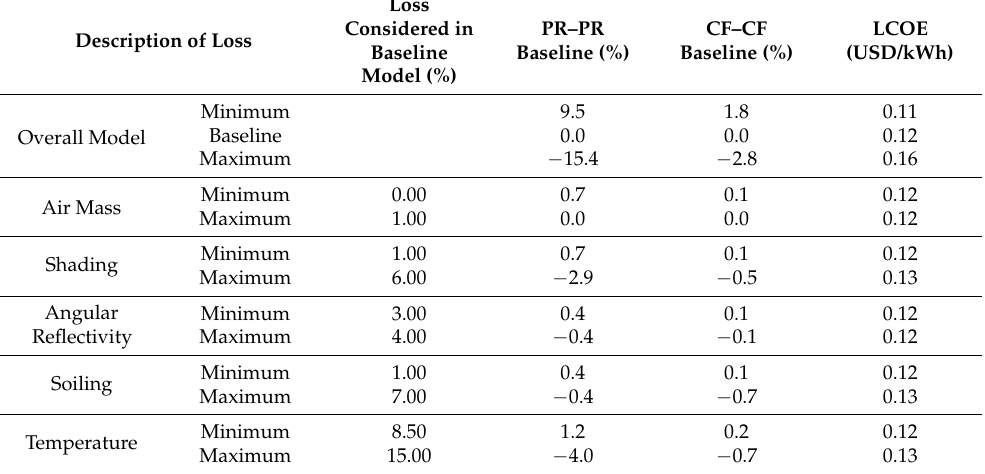
Table 5. Differences in performance ratio, differences in capacity factor and the LCOE of the isolated effects of the maximum and minimum losses compared with baseline values for air mass, shading, angular reflectivity, soiling and temperature for a 50 MW